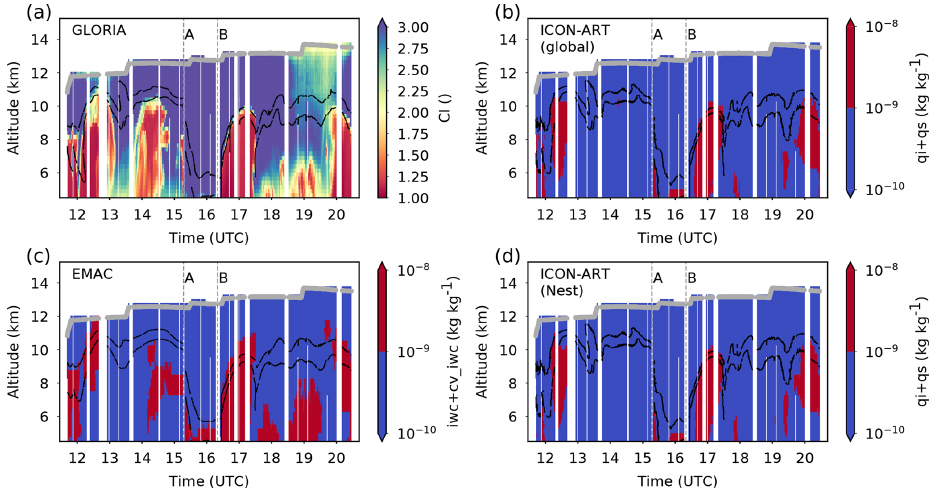
Figure 5. Qualitative comparison of clouds along the flight track observed by GLORIA and cloud masks generated from ICON-ART and EMAC. (a) Vertical cross section of cloud index (CI) derived from GLORIA spectra. (b, d) Cloud mask constructed from global and nested ICON-ART domain of specific cloud ice content plus snow mixing ratio. (c) Cloud mask constructed from EMAC large-scale snow and ice content plus convective cloud snow and ice content. Black lines: 2 and 4PVU isolines (lower and higher lines, respectively) from ECMWF reanalysis (a) , ICON-ART (b, d) and EMAC (c) as indicators for the dynamical tropopause. Grey lines: HALO flight altitude.